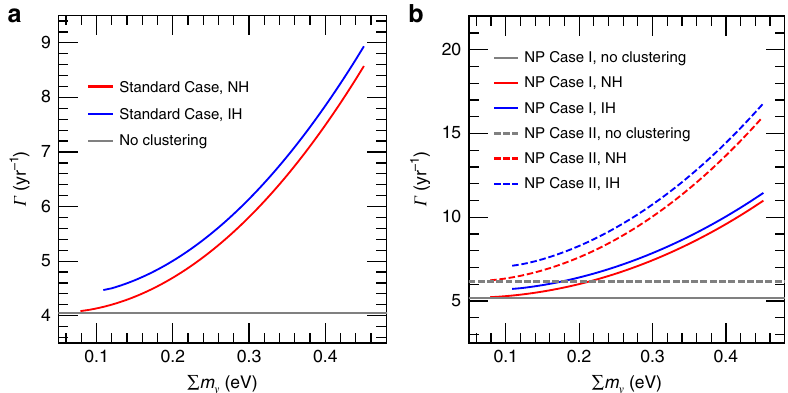
Fig. 3 Capture rate Γ in the PTOLEMY experiment. a Standard Case refers to the scenario predicted by the standard model of cosmology, i.e., only the left (right)-handed chiral states of (anti-)neutrinos were thermally produced in the early Universe. NH (IH) stands for the normal (inverted) mass hierarchy of neutrinos. b NP Case I and II are two new physics scenarios, and in both of them the thermal history of the left(right)-handed chiral states of (anti-) neutrinos is the same as Standard Case. In NP Case I the right(left)-handed chiral states of (anti-)neutrinos were also thermally produced in the early Universe, while in NP Case II the right(left)-handed chiral states of (anti-)neutrinos are non-thermal and possess the fully-degenerate phase space distribution. The number density of the right-handed chiral states of neutrinos is taken to be 28% (52%) of that of the left-handed chiral states of neutrinos in NP Case I (II), when neutrinos began